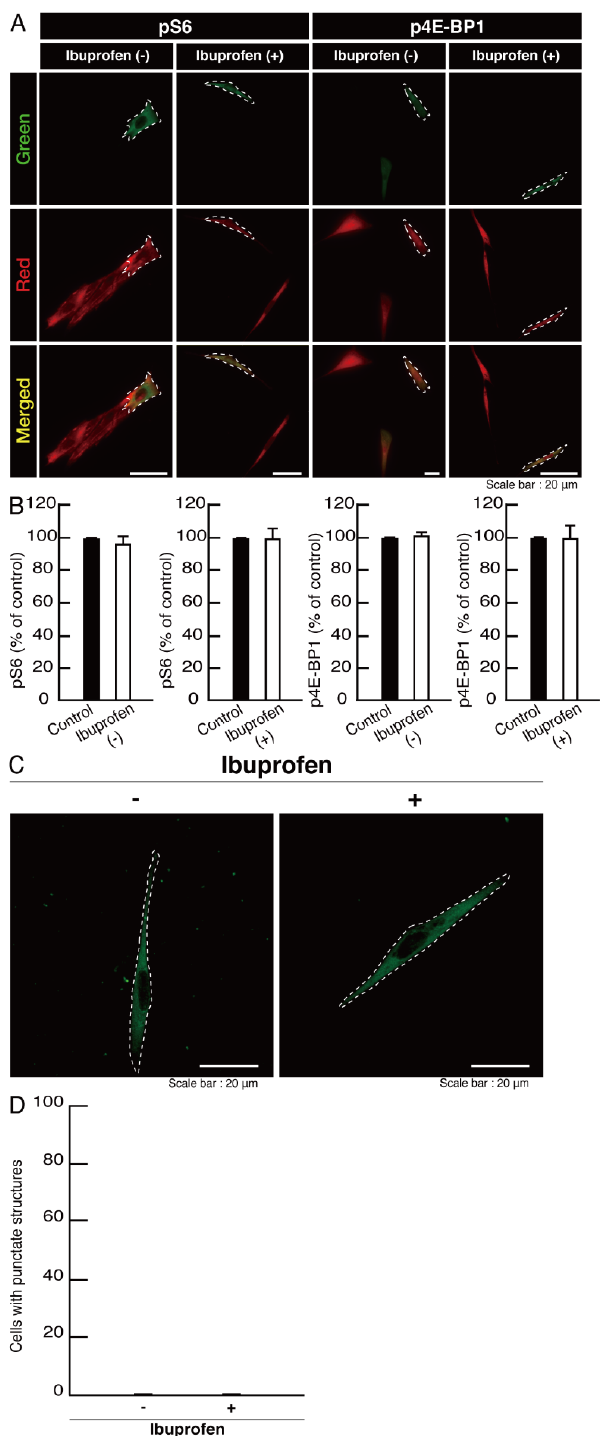
Figure 14. Ibuprofen does not have significant effects on phosphorylation levels of ribosomal S6 and 4E-BP1 proteins and aggregate-like punctate structures in cells harboring the wild type POLR3B. ( A , B ) Cells harboring the wild type (green) in the presence or absence of ibuprofen were stained with an anti-(pS240 and pS244)ribosomal S6 protein (pS6) or anti-(pT37)4E-BP1 (p4E-BP1) antibody (red). Their phosphorylation levels are shown statistically compared to those in their respective control cells under each image ( n = 3 fields). ( C , D ) Cells harboring the wild type (green) were treated with or without ibuprofen. The percentage of cells with punctate structures were statistically assessed ( n = 3